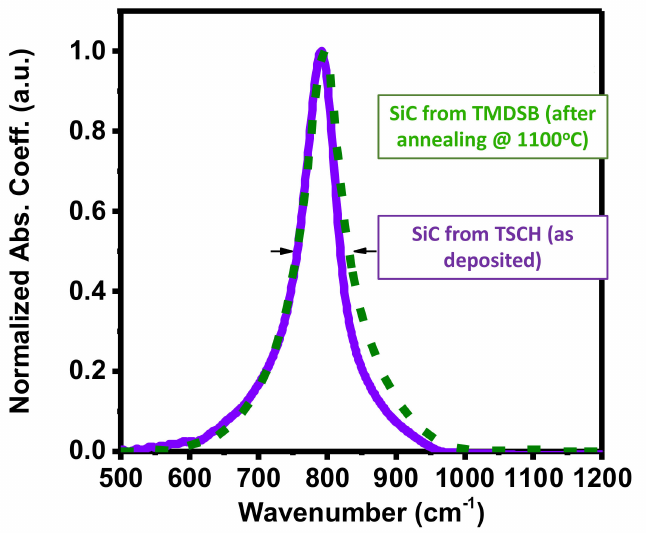
Figure 4. FTIR-normalized absorbance coefficient for as-deposited SiC films using TSCH as the Si precursor compared to post-annealed SiC films grown using